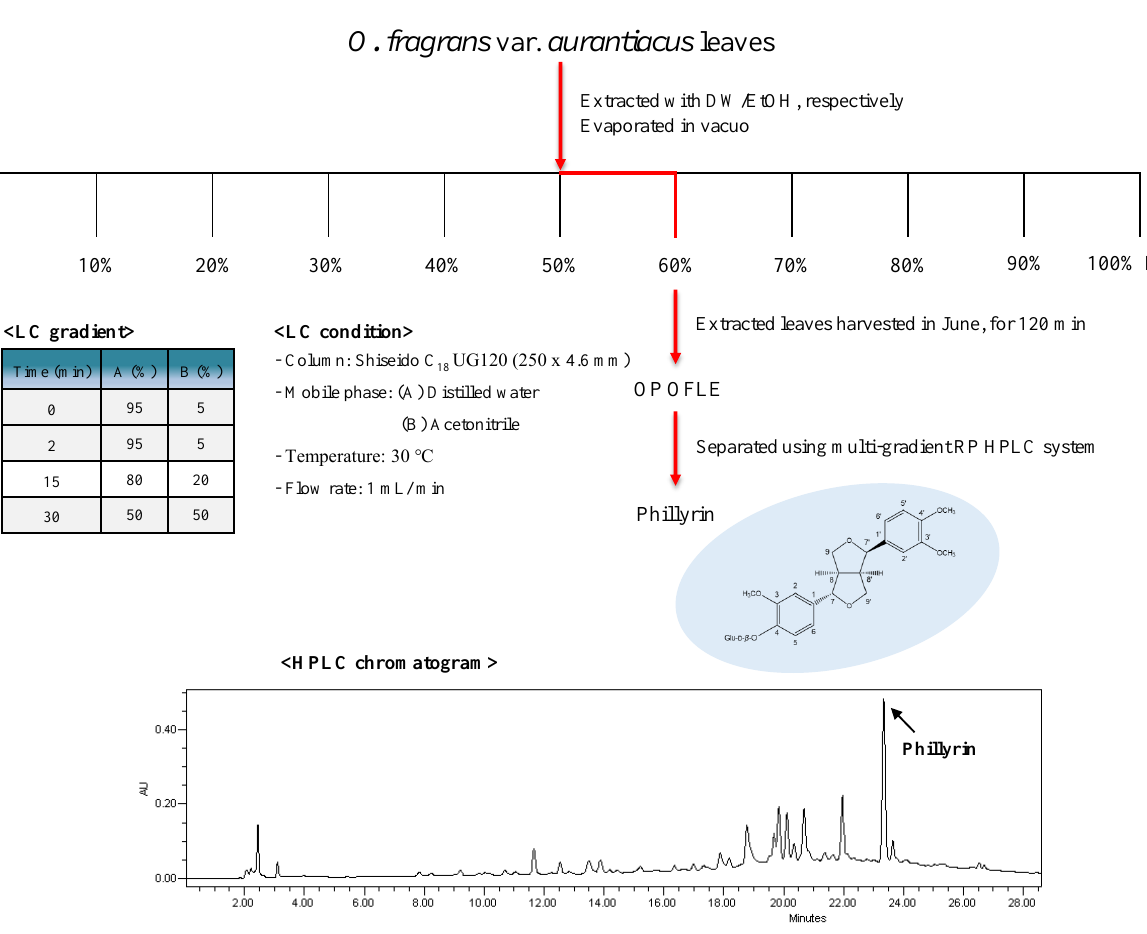
RAW 264.7 cells were used to determine the effects of OP OFLE (50, 100 µ g/mL) and PH (100, 200 µ M) on protein expression. As shown in Figure 7, iNOS and COX-2 protein levels were increased significantly in the group induced with LPS without any pretreatment. However, pretreatment with OP OFLE or PH resulted in dose-dependent decreases of these protein expression levels induced by LPS. Compared to the control group without any pretreatment, OP OFLE at 100 µ g/mL and PH at 200 µ M reduced iNOS protein expression by 91.7% and 92.5%, respectively. Additionally, we assessed effects of OP OFLE and PH on COX-2 protein through Western blot analysis. Both OP OFLE and PH inhibited its expression. Pretreatment with OP OFLE at 100 µ g/mL showed the highest inhibitory effect on COX-2 protein expression, resulting in a 41.8% reduction. PH at 100 and 200 µ M also attenuated the expression of COX-2 protein upregulated by LPS stimulation by 54.9% and 91.8%, respectively. The expression of LPS-stimulated COX-2 protein was inhibited by 41.8% and 91.8% after treatment with OP OFLE (100 µ g/mL) and PH (200 µ M), respectively (Figure